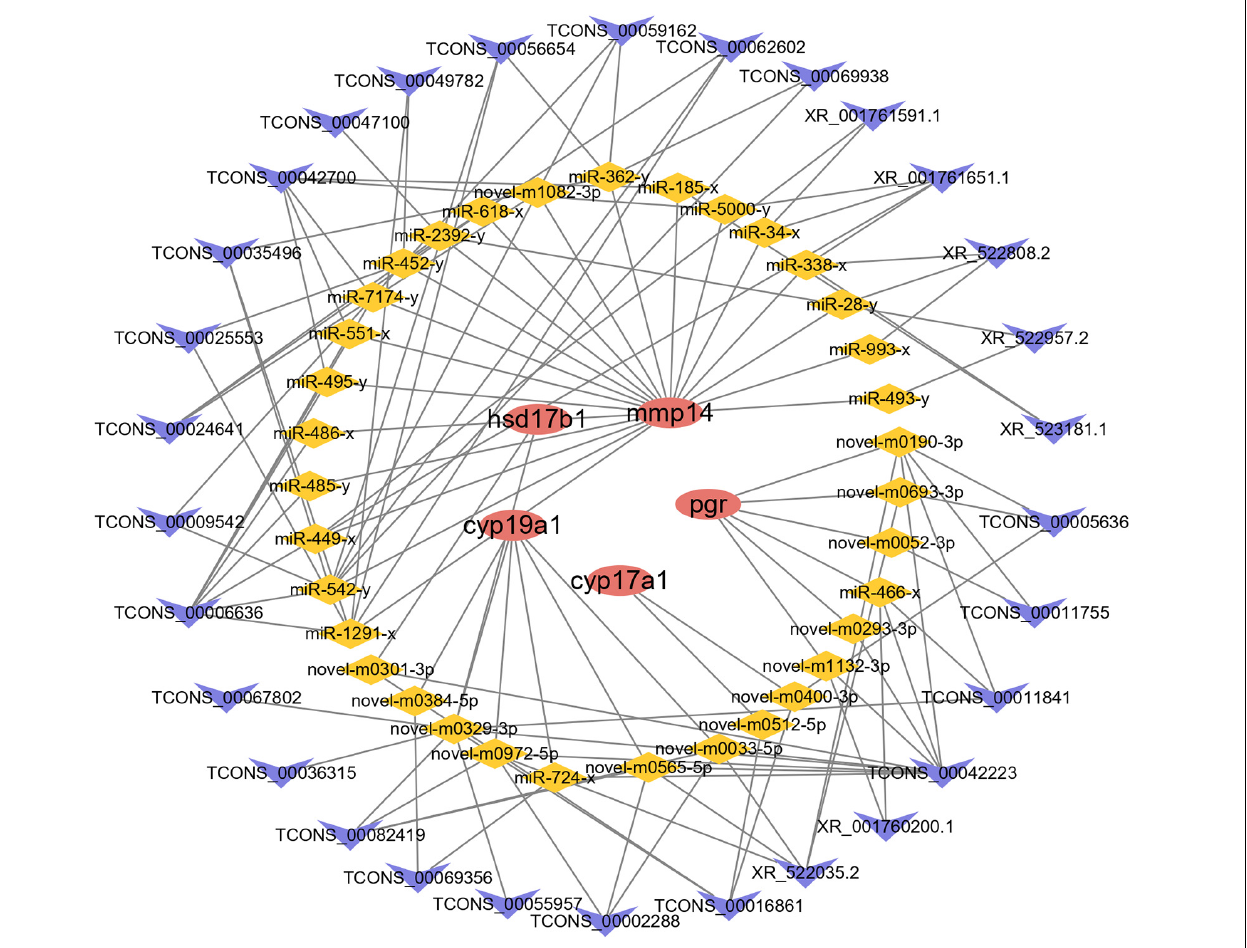
FIGURE 6 | The ceRNA network of cyp17a1 , cyp19a1 , mmp14 , pgr , and hsd17b1. Red ellipse represents mRNAs, yellow diamond represents miRNAs, and blue “V” represents lncRNAs.